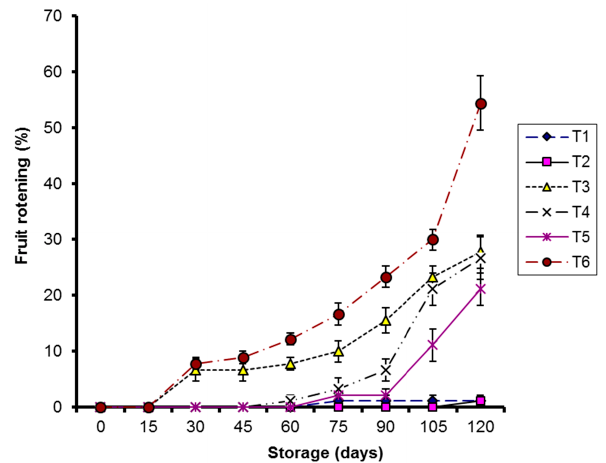
Figure 10. Effect of CMC and guargum-based silver nanoparticle coatings on the rotting of kinnow fruit stored at 4 and 10 °C during storage. The vertical bars represent standard error of the means. Values represented as mean ± SE of three replicates.